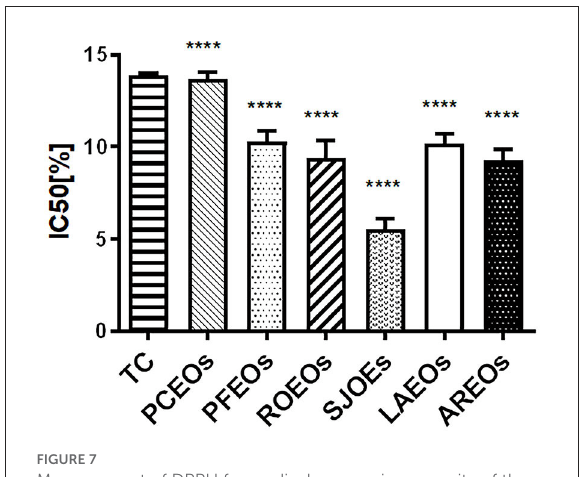
FIGURE7 Measurement of DPPH free radical scavenging capacity of the six Lamiaceae essential oils using Trolox C (TC) as the positive control. Statistical significance relative to the Trolox C (TC) group is indicated, **** p ≤ 0.0001 , significantly different from the positive control